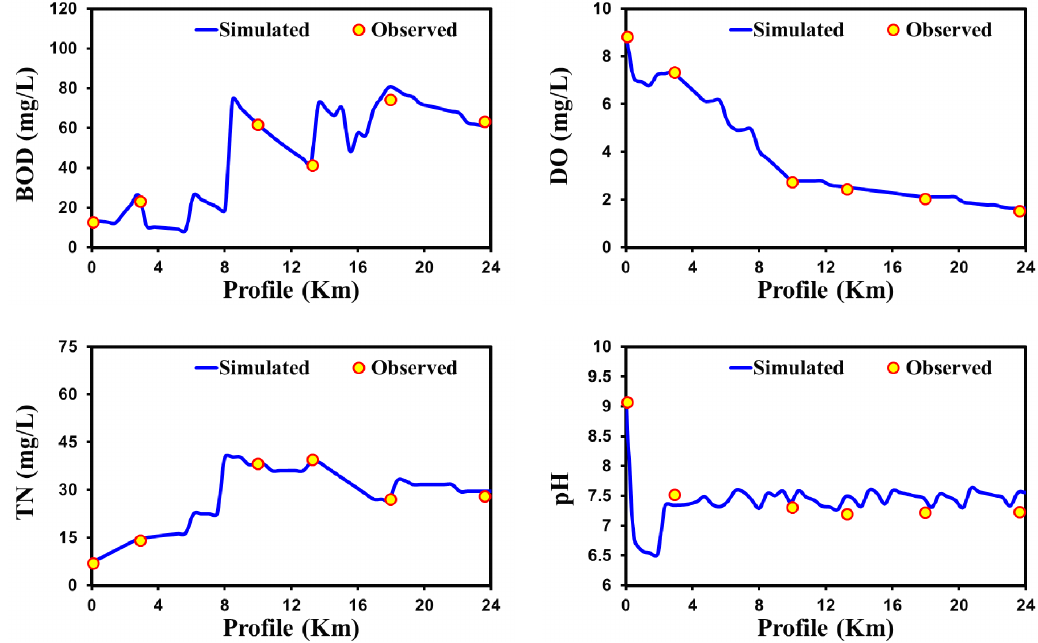
Figure 6. Confirmation of water quality model results in Baghmati River (temperate climatic region) for BOD, DO, TN, and pH.